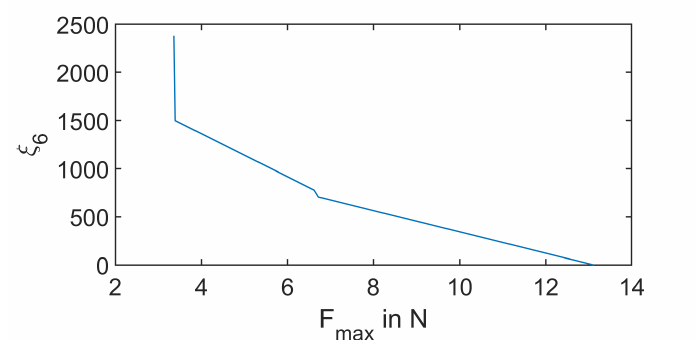
Figure 17. Dependency of ξ 6 on the magnitude of the excitation force.